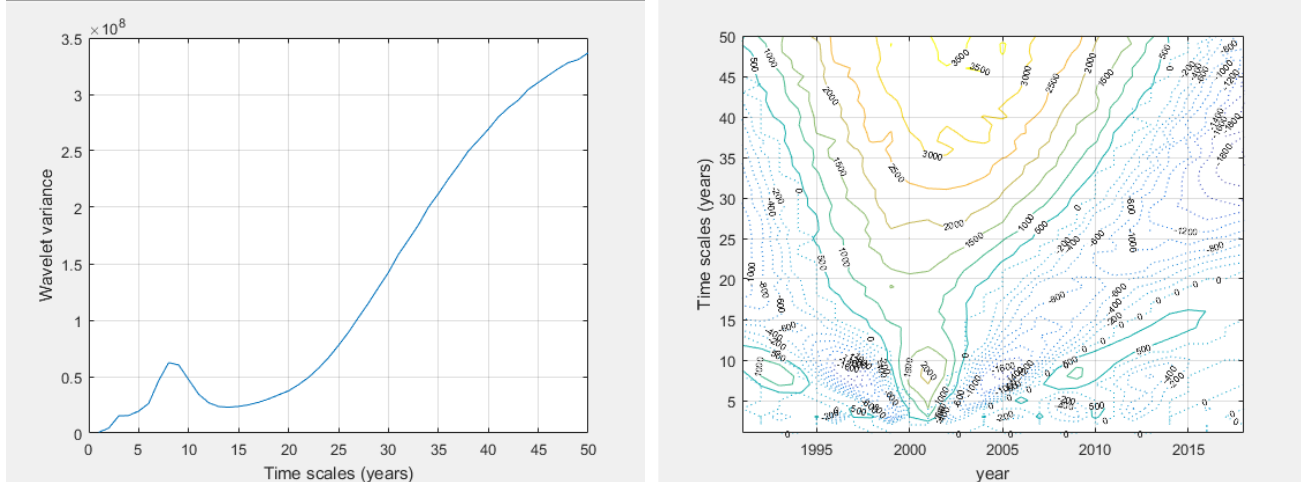
Figure 9. Wavelet square difference plot and the real part contour plot of the wavelet coefficients of the national crop failure area from 1991 to 2018.